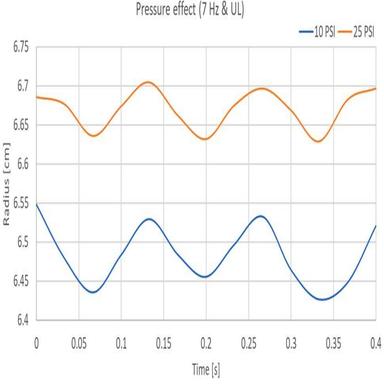
Radius – pressure effect (7 Hz & UL).